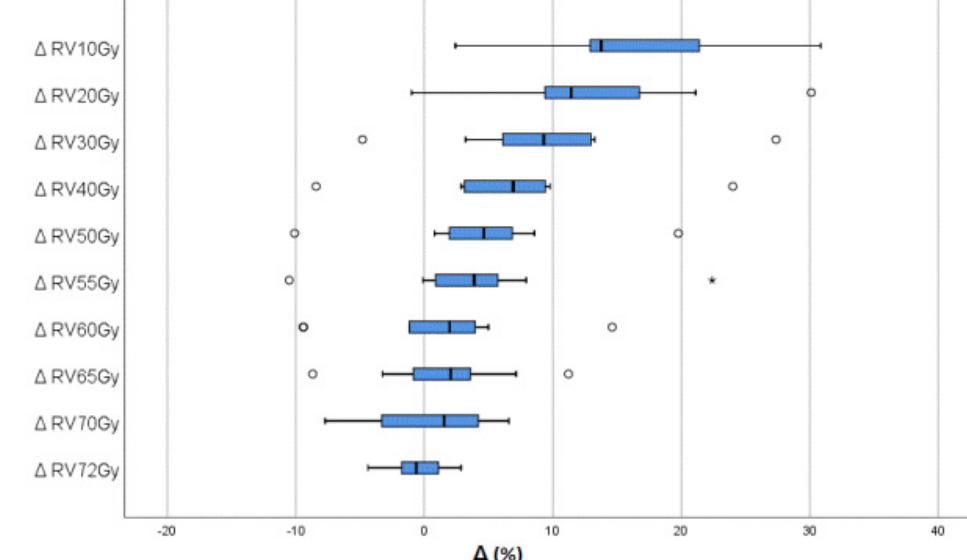
Figure 2. Box plot illustrates the difference ( ∆ ) in percentage of rectal volume received x dose between the non-ERB plans and ERB plans (mean value non-ERB plans- mean value ERB plans).